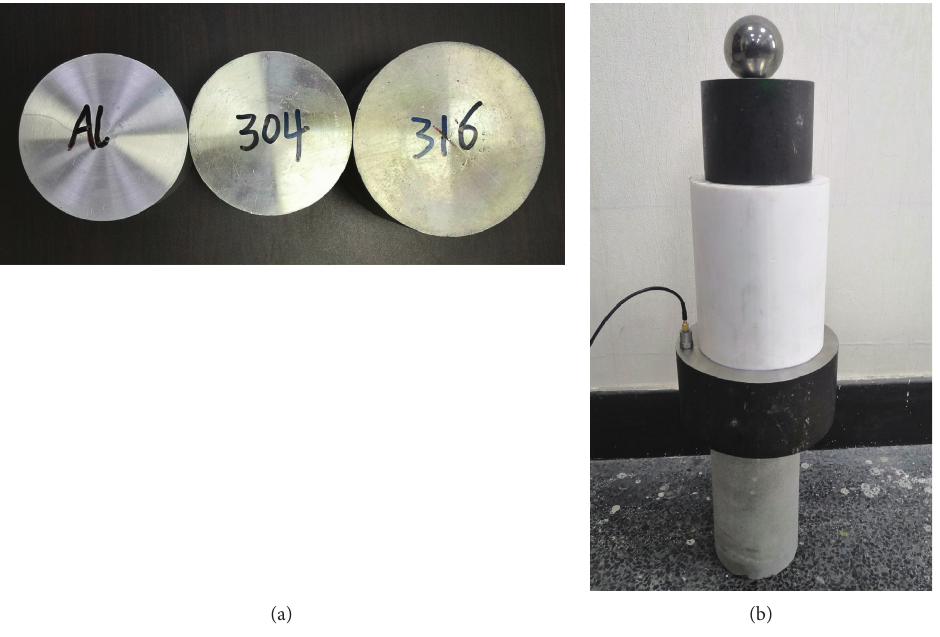
Figure 3: (a) Impacted metals and (b) impact